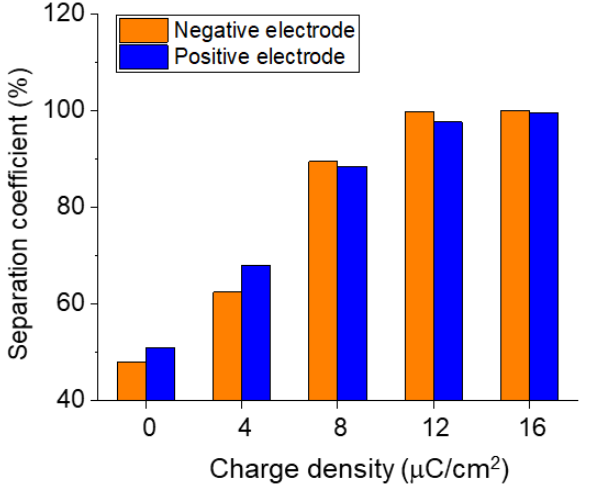
Figure 4. Separation coefficient at different surface charge densities.